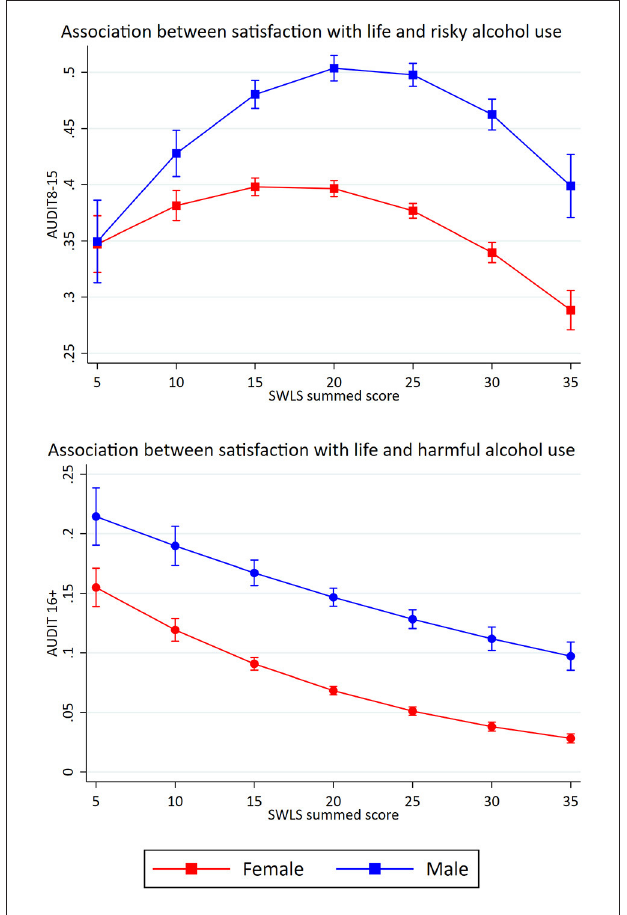
FIGURE 4 | Gender-specific associations between satisfaction with life and potential alcohol-related problems. Retained models. Predicted probabilities of alcohol-related problems (The Alcohol Use Disorders Identification test; AUDIT) across summed scores on satisfaction with life scale (SWLS). Error bars represent 95% confidence intervals.